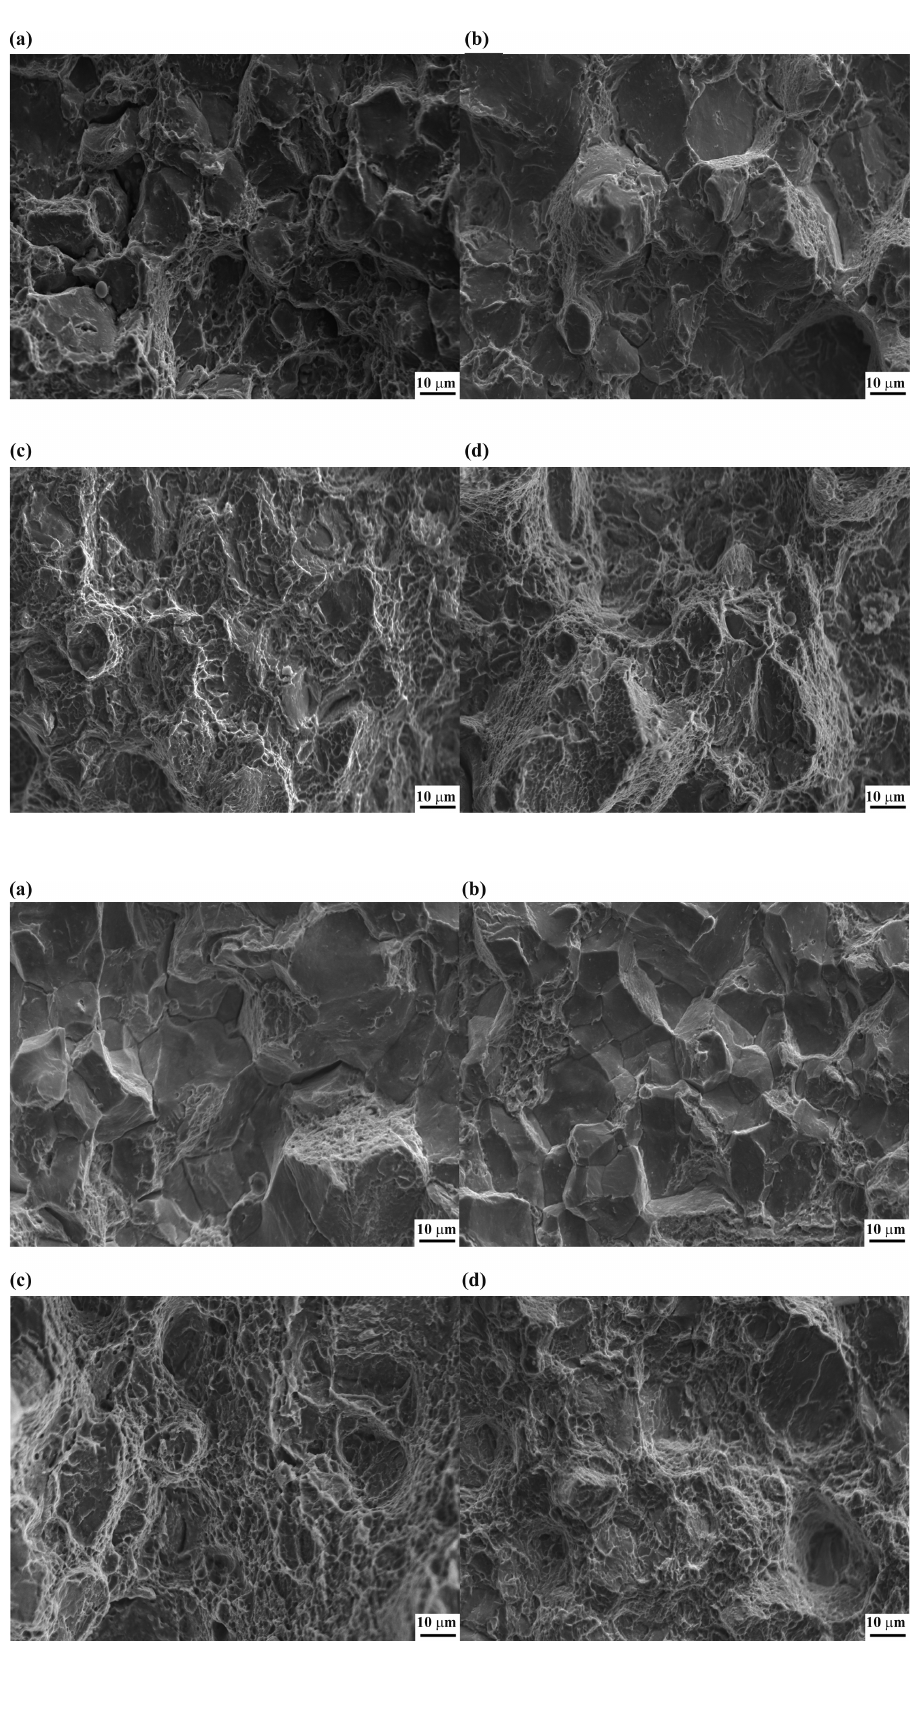
Figure 9: The impact fractures of the spring steels at different cooling rates: (a) 0.5°C/s, (b) 1°C/s: the reticular proeutec- toid ferrite; (c) 3°C/s, (d) 5°C/s: the blocky proeutectoid ferrite.